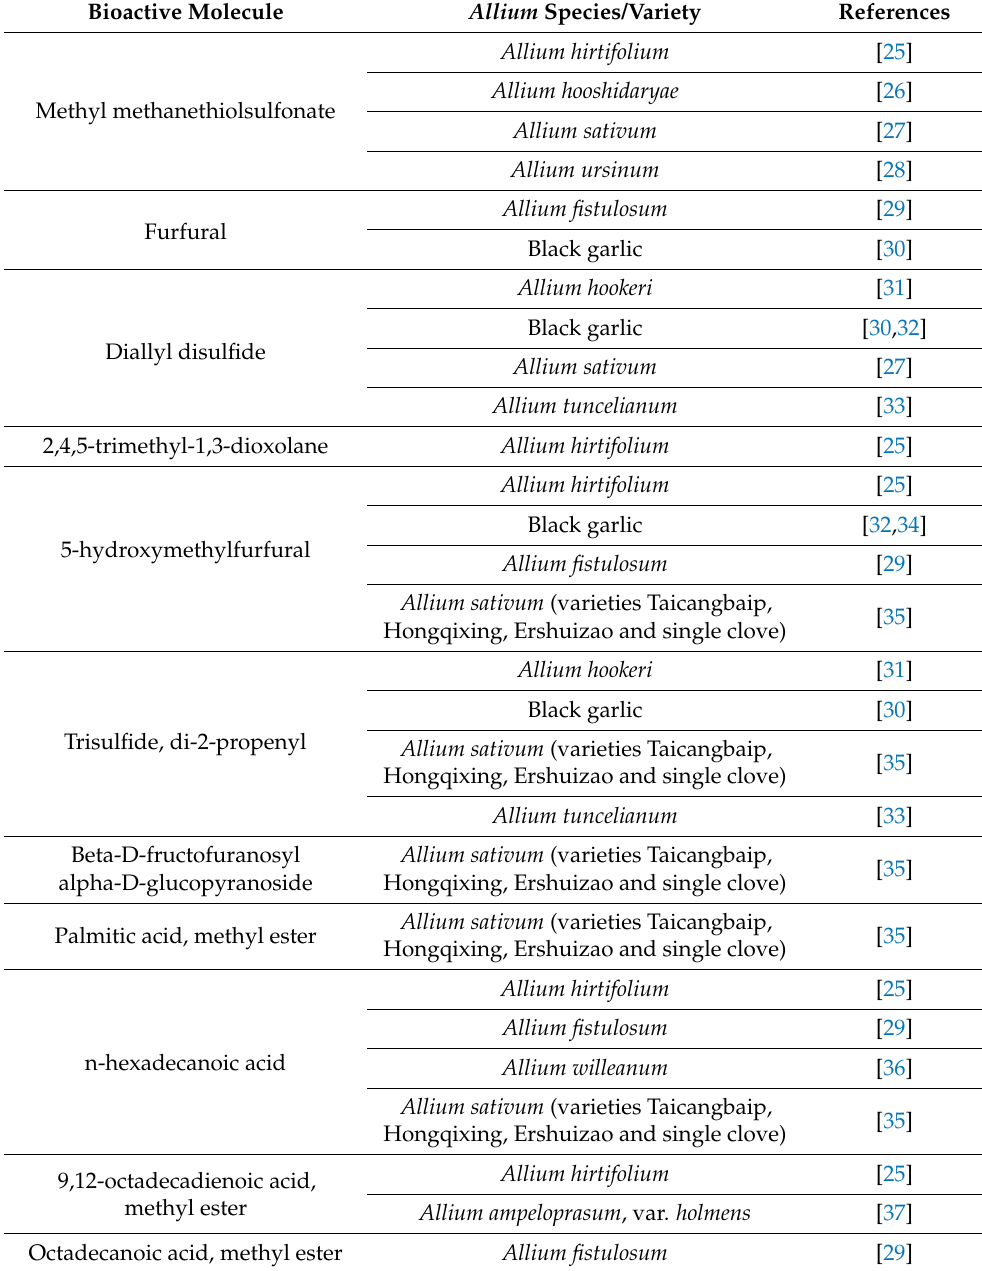
Table 9. Review of the distribution of some identified bioactive compounds in some Allium plant